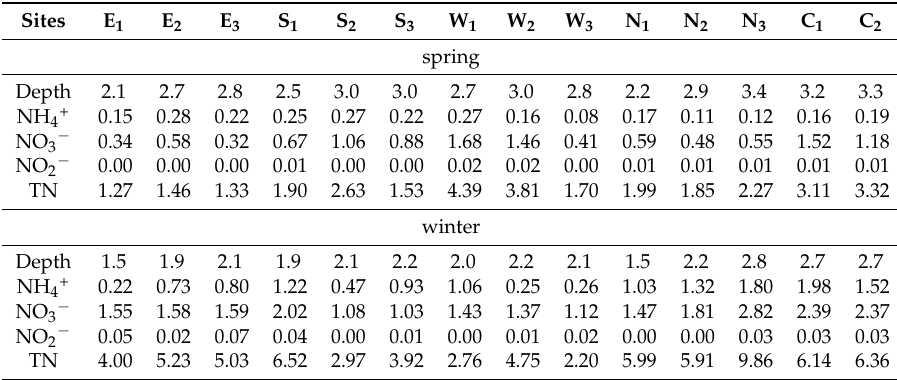
Table 1. Water depth (m) and nitrogen concentrations (mg L − 1 ) in bottom water at 14 sites of Lake Taihu during spring and winter